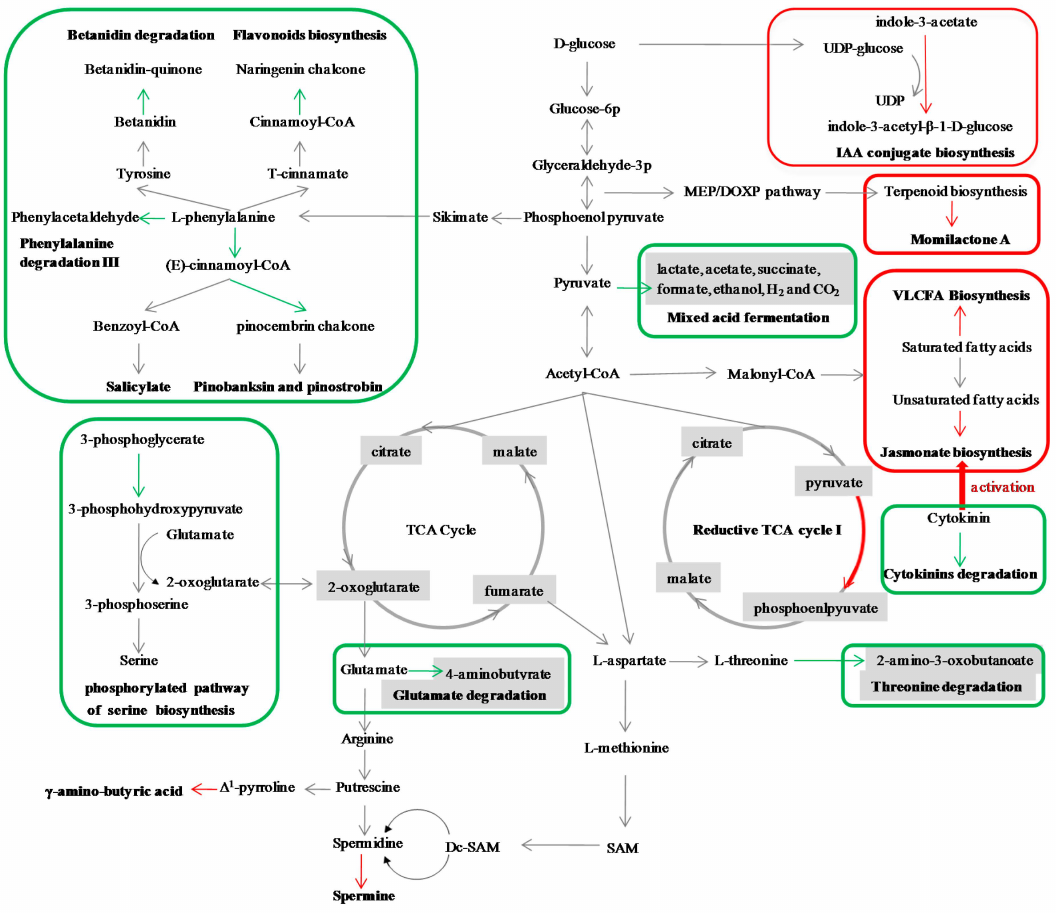
Figure 2. The network of the metabolic pathways potentially related to SBPH resistance in the SBPH-resistant rice plant. The up-regulated metabolic pathway was marked with red box and the red arrows denote the steps in the up-regulated metabolic pathways; the down-regulated metabolic pathway was marked with green box and the green arrows denote the steps in the down-regulated metabolic pathways. Abreviations: IAA, indole-3-acetic acid; SAM, S -adenosyl-methionine; Dc-SAM, decarboxylated S-adenosylmethionine; VLCFA, the very long chain fatty acid; TCA cycle, tricarboxylicacidcycle acid